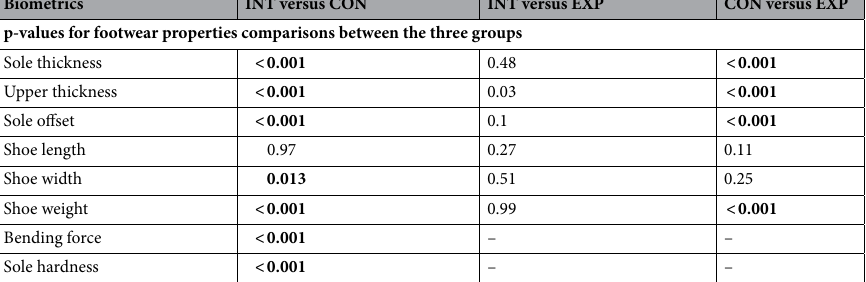
Biometrics INT versus CON INT versus EXP CON versus